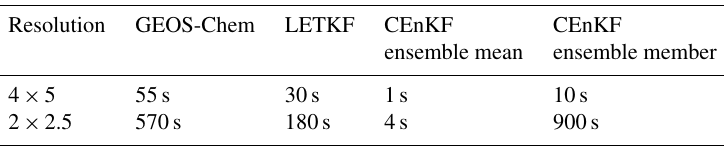
Table A1. The computational cost for one assimilation cycle (7d observation window). Each component is running in parallel, using 20 cores of Intel Xeon E5-2650. Note that the cost of the CEnKF with ensemble member constrained exceeds the cost of GEOS-Chem while increasing the horizontal resolution to 2 × 2.5.